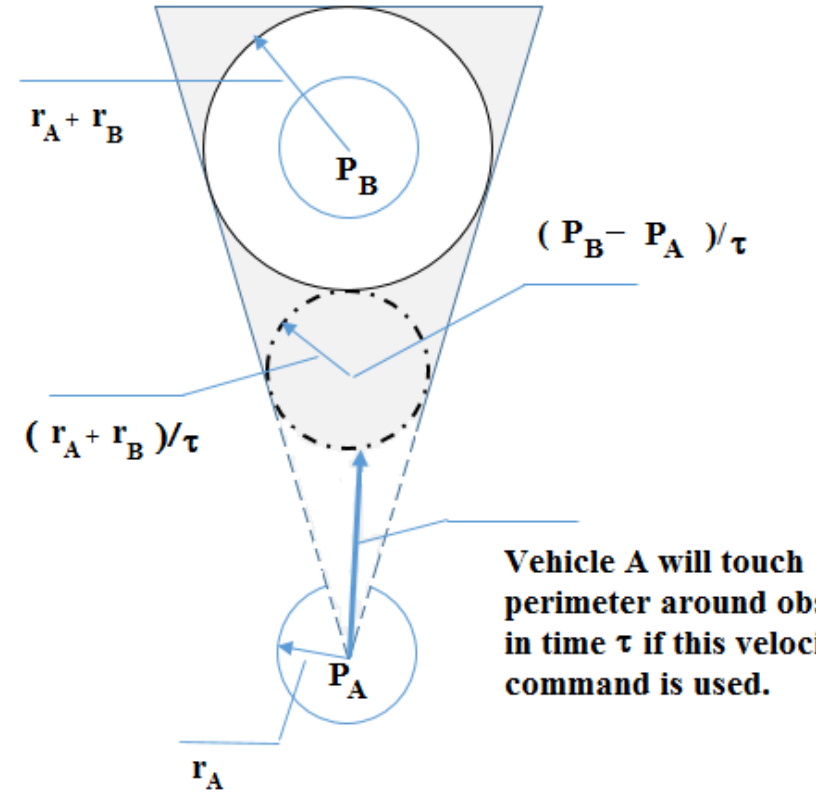
Figure 9. The velocity obstacle associated with a static circular obstacle. There is one vehicle A and one obstacle B with the respective radii r A and r B at the respective positions p A and p B . Vehicle A will touch the perimeter around obstacle B in time τ if using the command speed v CMD . At this moment, vehicle A ’s position is at ( p B − p A ) / τ